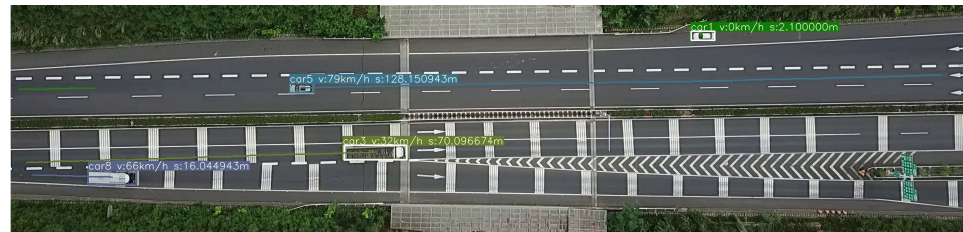
Figure 9. Result of vehicle detection. Table 4. Result of vehicle detection.